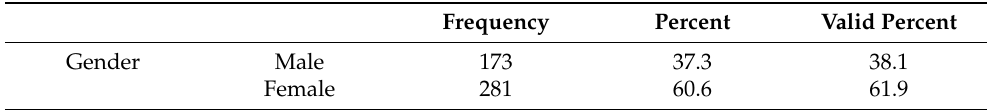
Table 3. A summary of the demographic factors of the participants (gender, nationality, language, age group, education, marital status, employments status and length of